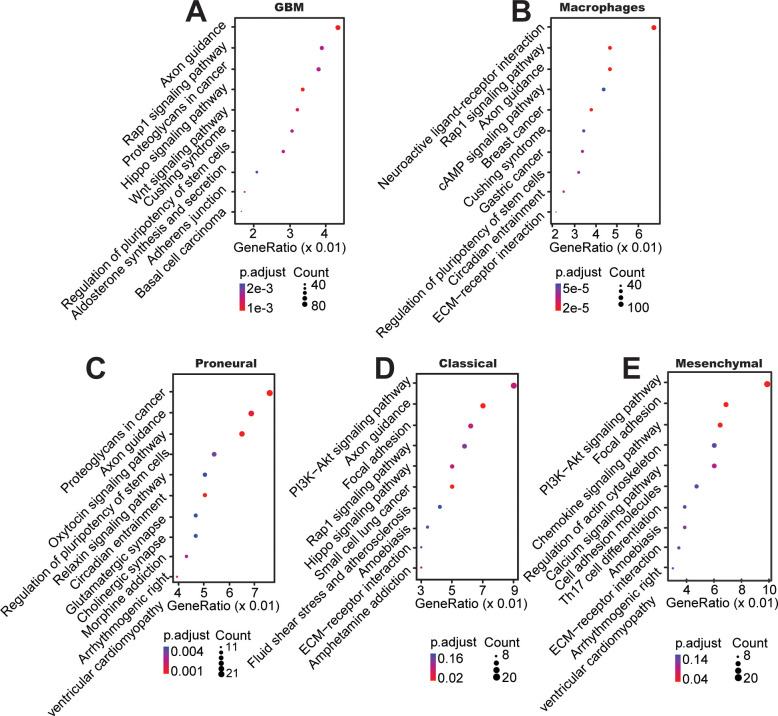
Top KEGG pathways between mono-cultured and co-cultured GBM cells in a 3D brain-mimicking ECM environment.(A) KEGG pathway analysis from whole genome DNA methylation comparing data from all glioma subtypes co-cultured with macrophages vs all mono-cultured glioma subtypes including PN (GBML20), CL (GBML08), and MES (GBML91) showing activation of pathways involved in axon guidance, Rap1, proteoglycans, and Wnt related signaling. (B) KEGG pathway analysis of macrophages co-cultured with all different types of GBM cells compared with mono-cultured macrophages showed relatively activation of pathways in neuroactive ligand-receptor, Rap1, axon guidance, cAMP related signaling. When DNA methylation data were analyzed for each molecular subtype of GBM, (C) co-cultured PN (GBML20) GBM cells showed relatively higher ratios of genes in proteoglycans, axon guidance, oxytocin, and pluripotency of stem cell related signaling compared to mono-cultured GBM cells, (D) co-cultured CL (GBML08) GBM cells showed relatively higher ratios of genes in PI3K−Akt, axon guidance, focal adhesion, and Rap1-related signaling pathways compared to mono-cultured GBM cells, and (E) co-cultured MES (GBML91) GBM cells showed relatively higher ratios of genes in PI3K−Akt, focal adhesion, chemokine, and actin-related signaling pathways compared to mono-cultured GBM cells.